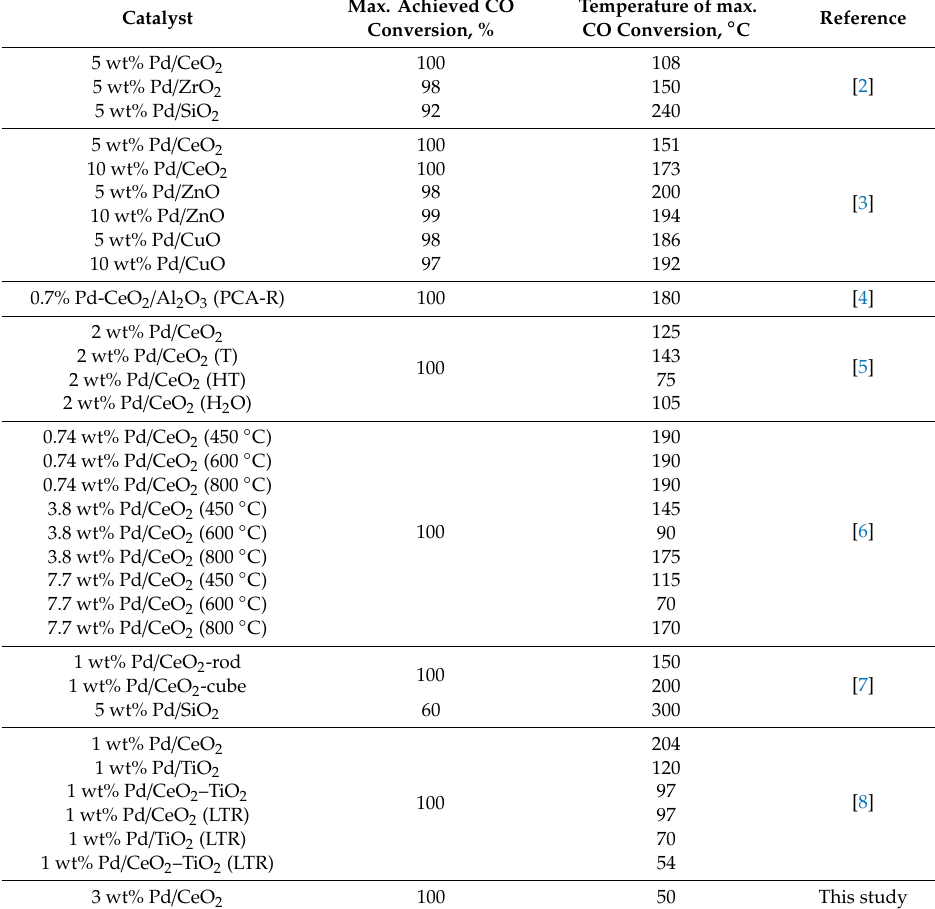
Table 1. Comparison of the catalytic activity of samples reported in the literature and in this study. Max. Achieved CO Catalyst Conversion,